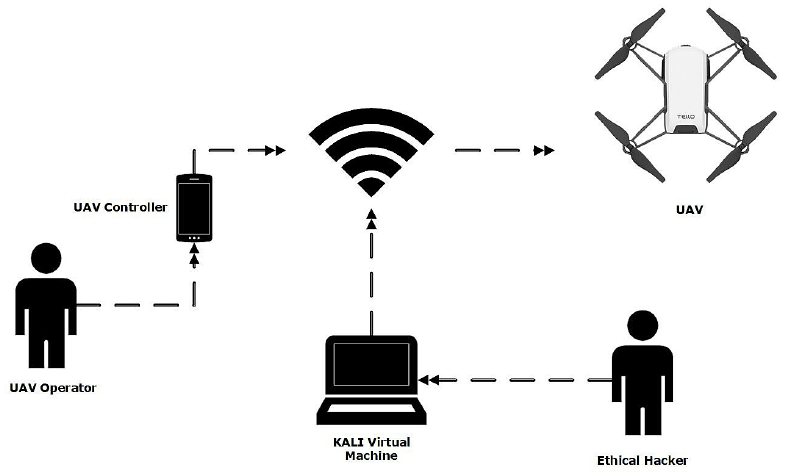
Figure 3. ECU-IoFT Dataset—Testbed Design.